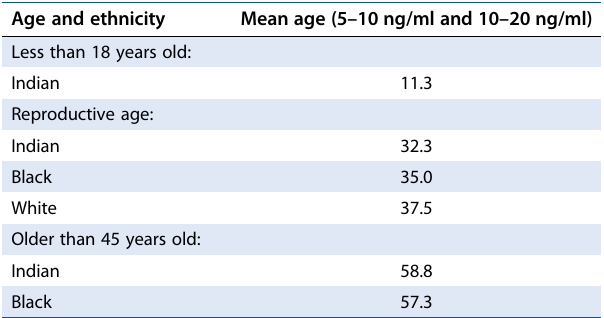
Table 4: Mean age and 25(OH)D deficiency Age and